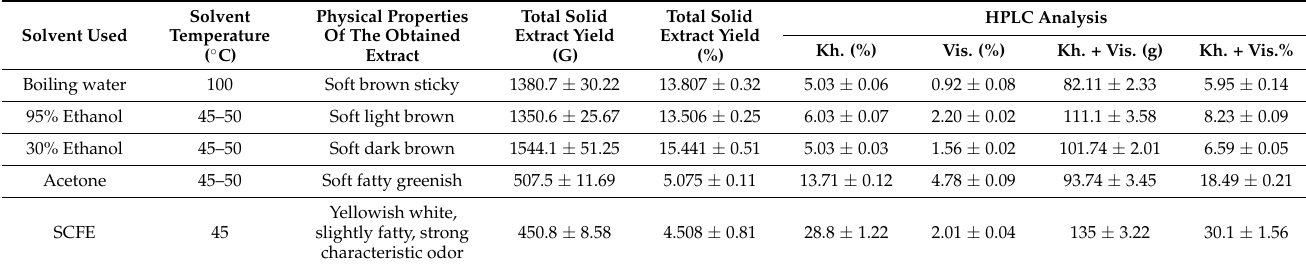
Table 1. Average yields and furanochromones content in A. visnaga tested